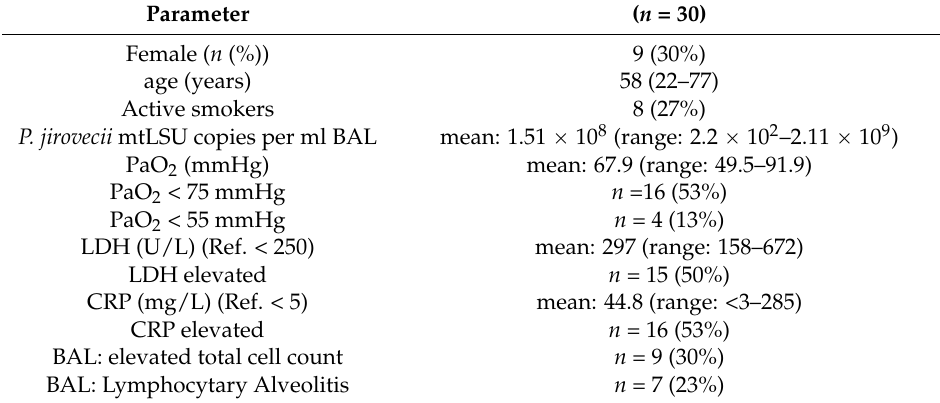
Table 1. Overview on the patient characteristics of 30 fully immunocompetent patients positive exclusively for P. jirovecii extracted out of the entire cohort for which full medical records were